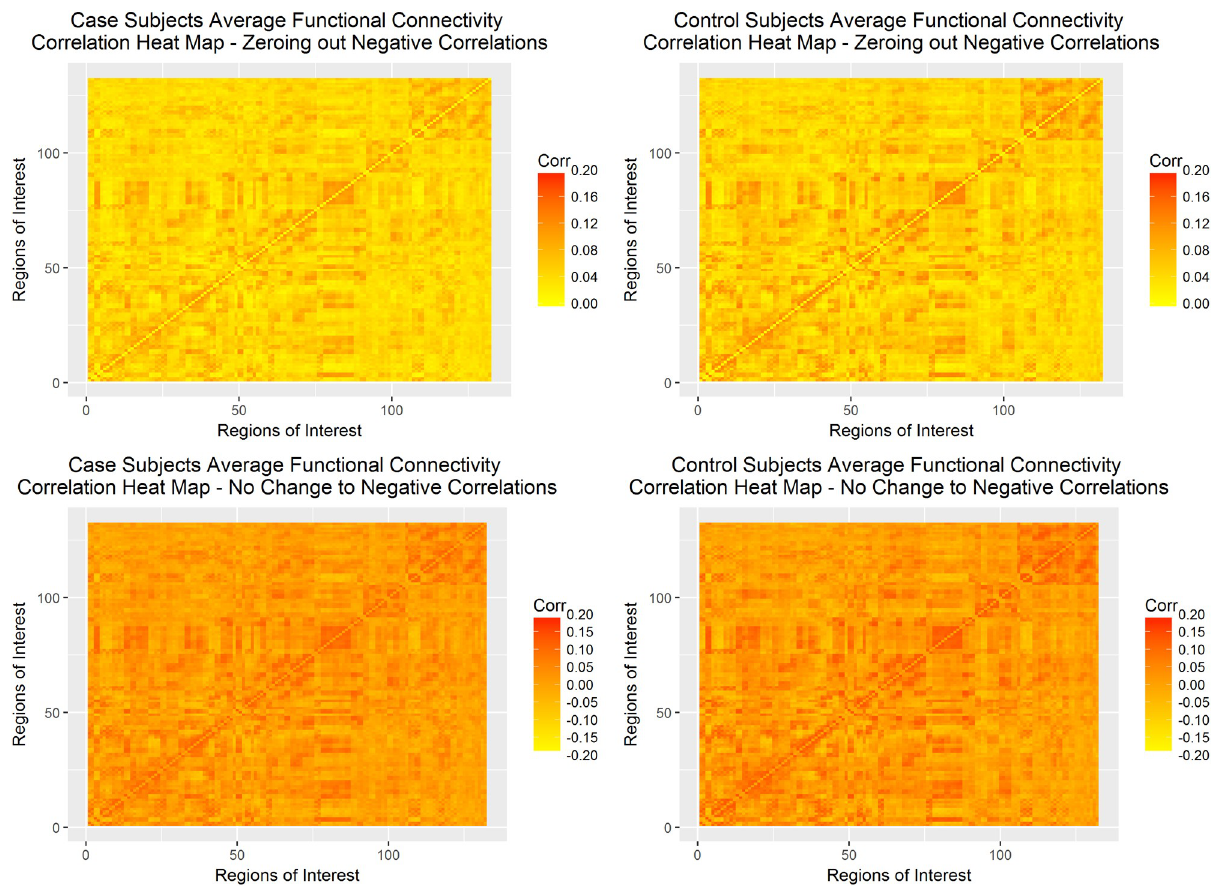
Fig 8. Correlation heat maps full COBRE-I dataset. Correlation heat maps of control and schizophrenia subjects under zeroing out negative correlations (top row) and normalizing all correlations (bottom row).